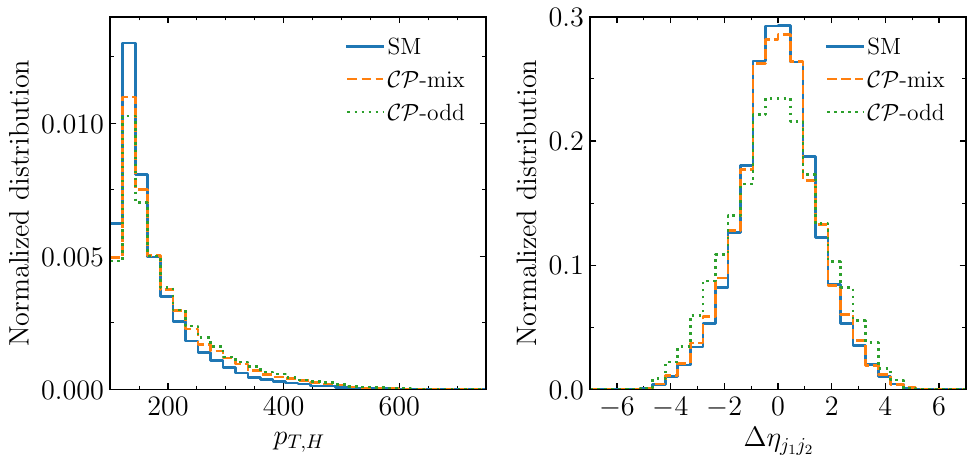
Figure 3 . Normalized distribution of p T,H and ∆ η j with c t = 1 , ˜ c t = 0 and c V = 1 (blue solid), CP -mix with c t = ˜ c t = 1 . 2 and c V = 1 (orange dashed), as well as CP -odd with c t = 0 , ˜ c t = c V = 1 (green